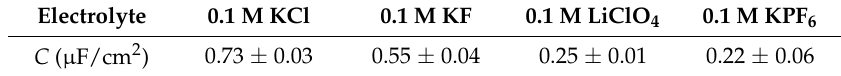
Table 1. Capacitance ( C ) results of the FS-SAM-modified gold electrodes in different electrolytes.